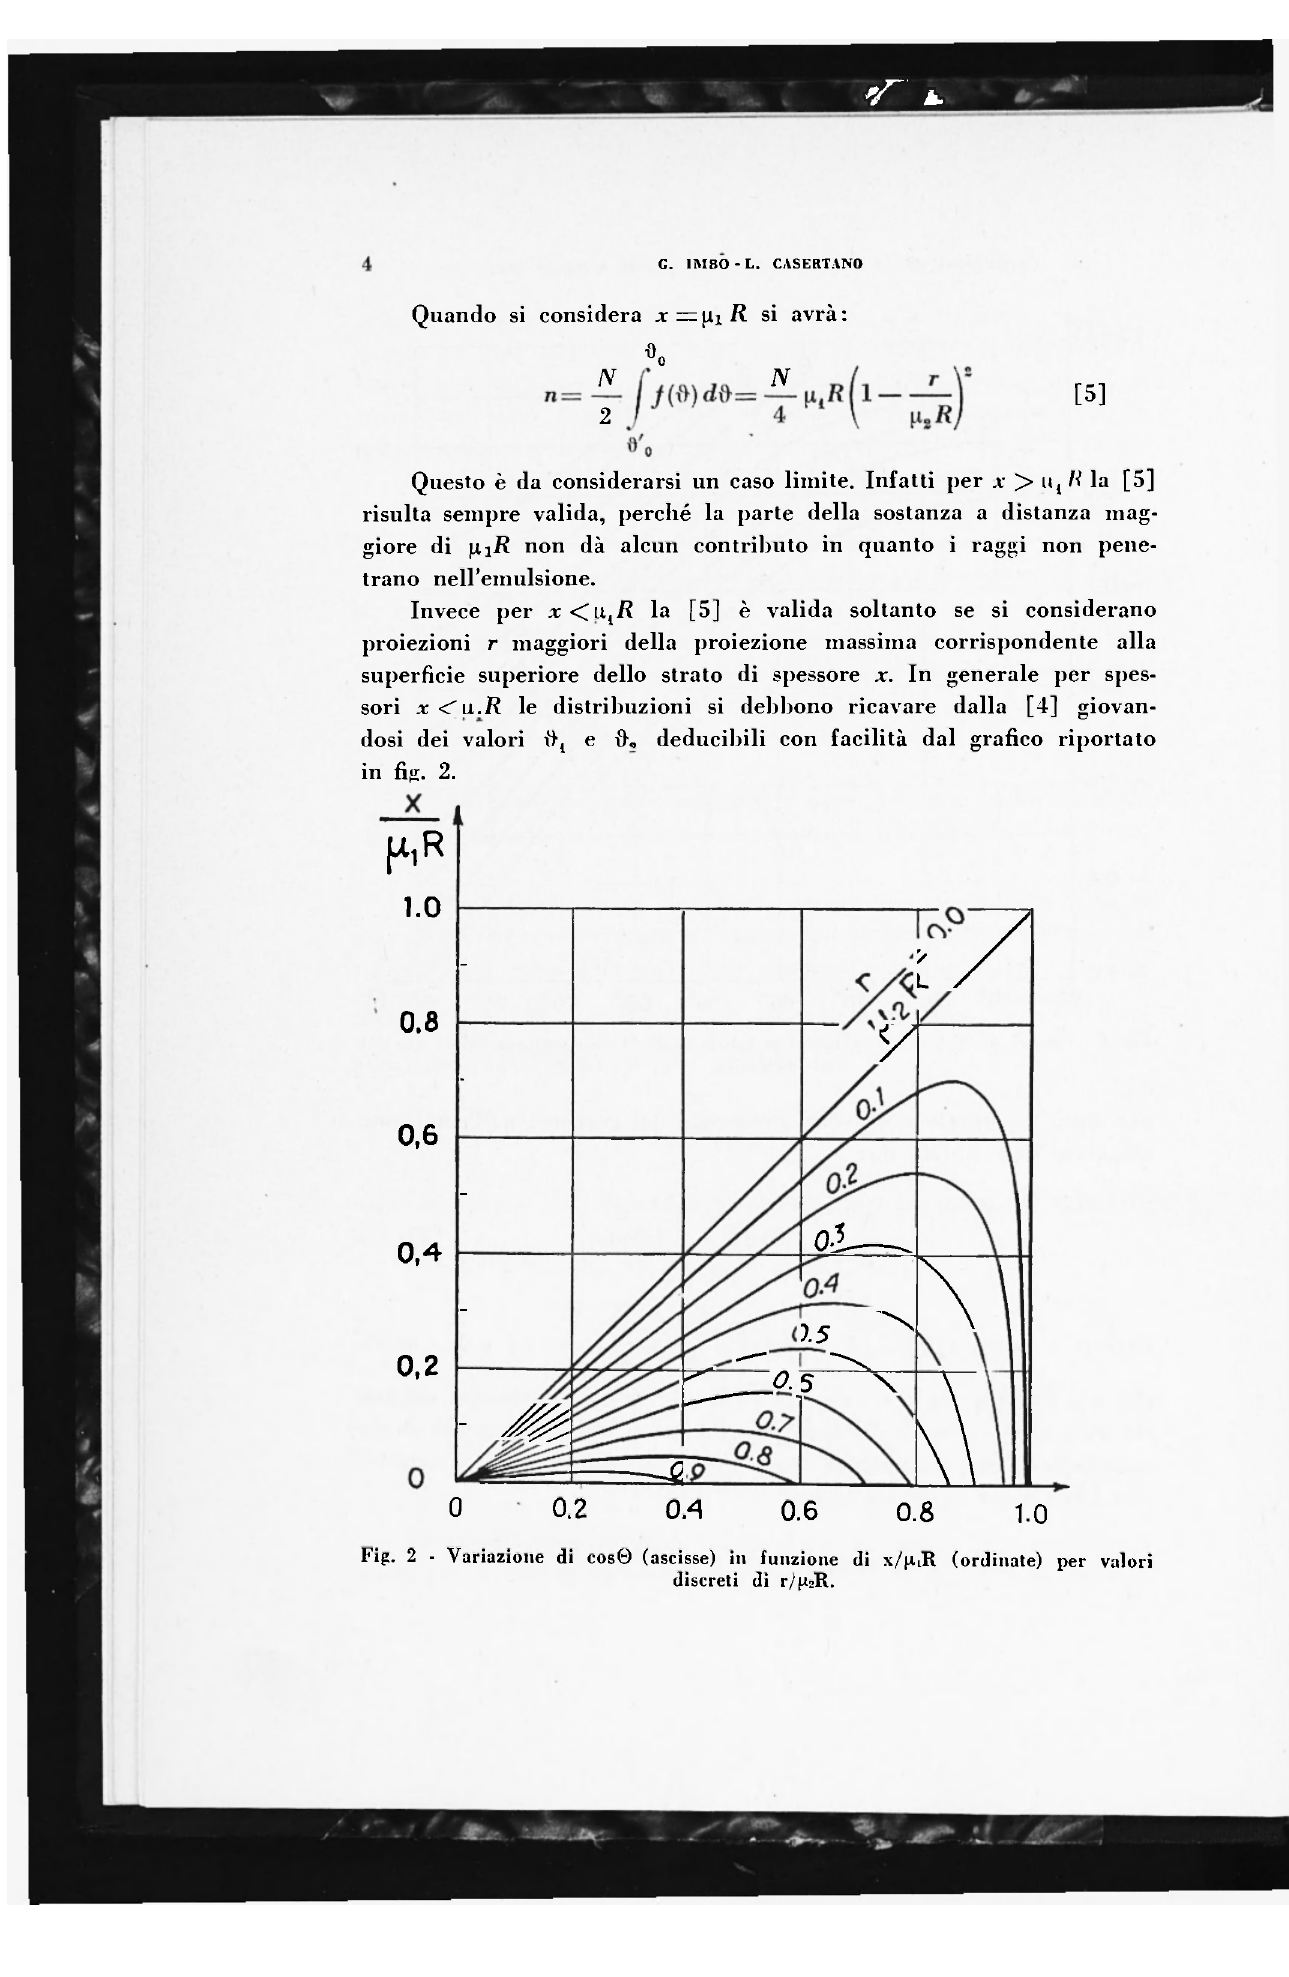
Fig. 2 - Variazione di cos0 (ascisse) in funzione di X/[ÌLR (ordinate) per valori discreti di r/(i 2